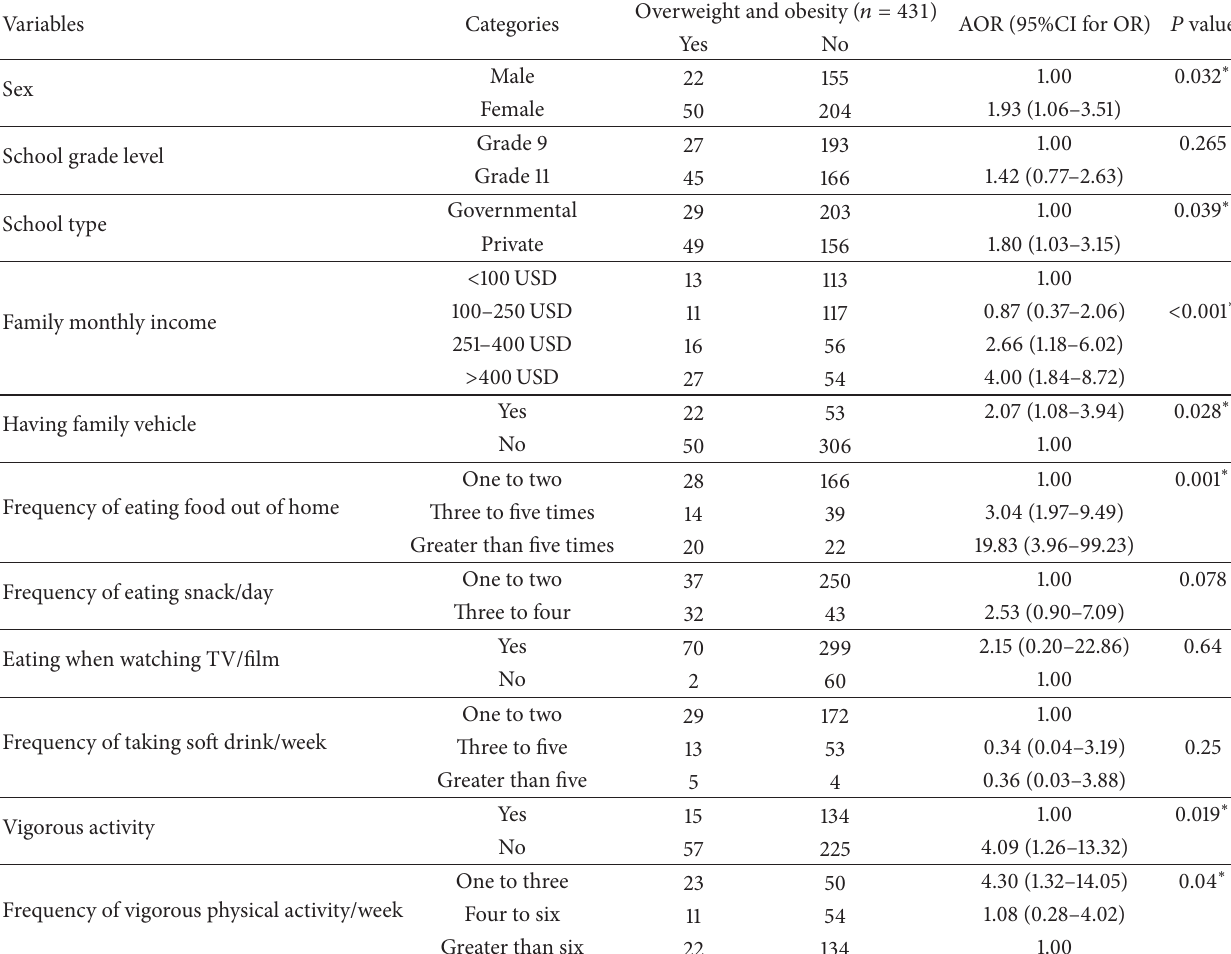
Table 6: The association between selected predictor variables and overweight and obesity among high school students in Bahir Dar city, North West Ethiopia,